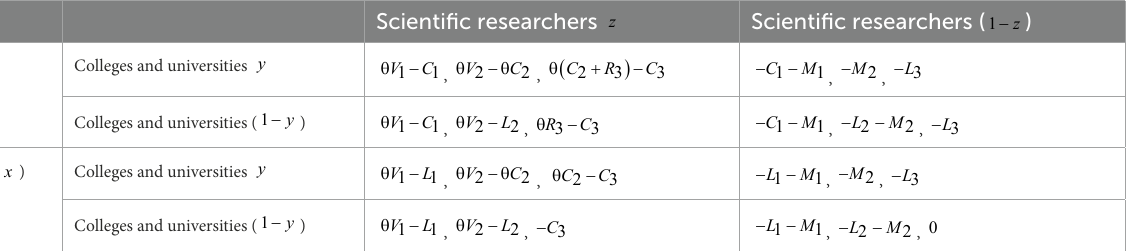
TABLE 2 Income matrix of countries, universities, and